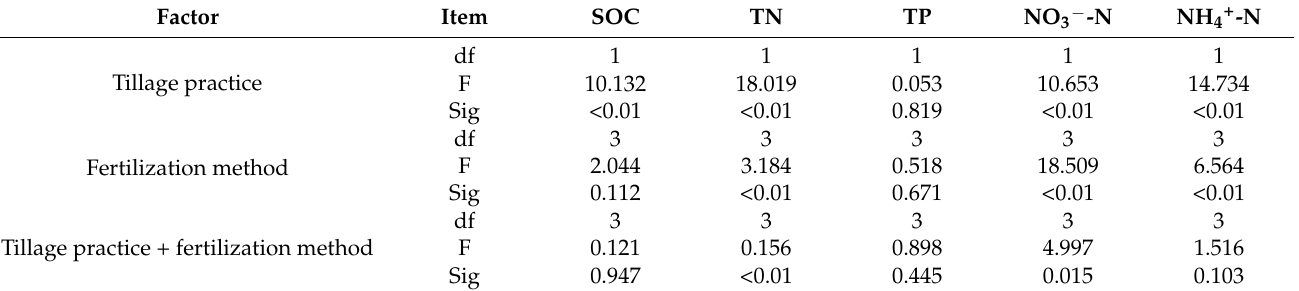
Table 4. Two-way factor ANOVA of (SOC, TN, TP, NO 3 − -N, and NH 4+ -N) under different treatments.